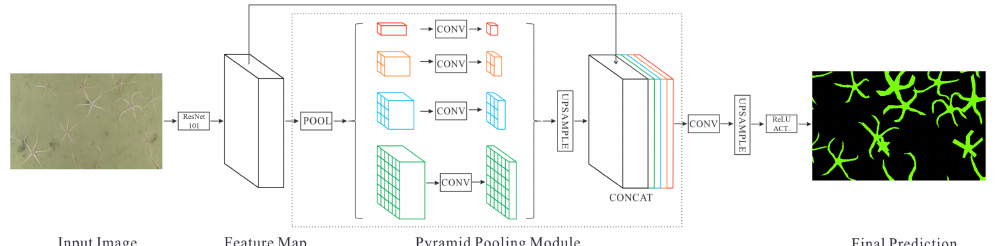
Figure 4. The input to the network is a patch of the mosaic, the output - semantic segmentation mask. Adapted from Ref. [22]. Since the feature map output by the ResNet-101 backbone is 1/8 the input image size, the pyramid pooling module is followed by upsampling through bilinear interpolation to get a segmentation mask of proper dimensions.